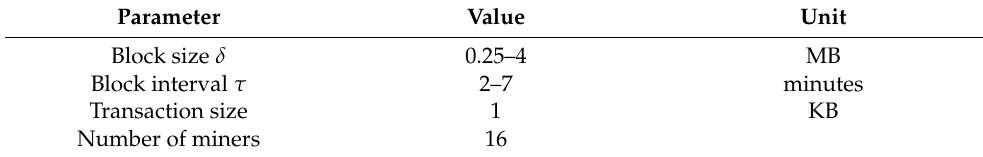
Table 1. Simulation